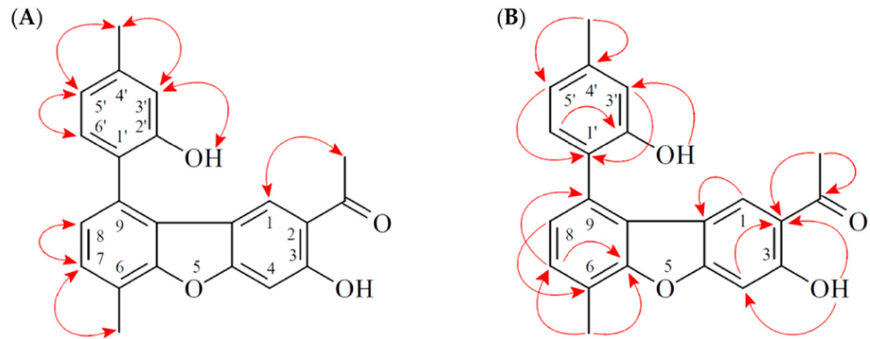
Figure 2. Key ROESY ( A ) and HMBC ( B ) correlations of 1 . Compound 2 was isolated as amorphous powder with molecular formula C 23 H 20 O 4 , Table 1. 1 H and 13 C NMR data of 1 and 2 . as determined by positive-ion HRESIMS, showing an [M + Na] + ion at m/z 383.12612 (calcd for C 23 H 20 O 4 Na, 383.12593). The presence of a conjugated carbonyl group was revealed by a band at 1645 cm − 1 in the IR spectrum, and was confirmed by the resonance at δ C 203.7 in the 13 C NMR spectrum. The 1 H NMR data of 2 were similar to eupatodibenzofuran A ( 1 ), except that the 2 (cid:48) -methoxy group [ δ H 3.70 (3H, s), δ C 55.5] of 2 replaced the 2 (cid:48) - hydroxy group [ δ H 4.97 (1H, s)] of 1 . This was supported by the ROESY correlations between OMe-2 (cid:48) ( δ H 3.70) and H-3 (cid:48) ( δ H 6.91) and by the HMBC correlations between OMe- 2 (cid:48) ( δ H 3.70) and C-2 (cid:48) ( δ C 156.7) (Table 1). The position of each substituent was supported by ROESY correlations between H-1 ( δ H 7.59)/Ac-2 ( δ H 2.40), Me-6 ( δ H 2.60)/H-7 ( δ H 7.27), H-7 ( δ H 7.27)/H-8 ( δ H 7.17), OMe-2 (cid:48) ( δ H 3.70)/H-3 (cid:48) ( δ H 6.91), H-3 (cid:48) ( δ H 6.91)/Me-4 (cid:48) ( δ H 2.49), and Me-4 (cid:48) ( δ H 2.49)/H-5 (cid:48) ( δ H 6.95) and by HMBC correlation between ‘H-1 ( δ H 7.59)/MeCO-2 ( δ C 203.7), C-3 ( δ C 162.9), C-4a ( δ C 161.3), C-9a ( δ C 121.7)’, ‘Ac-2 ( δ H 2.40)/C-2 ( δ C 116.0)’, ‘OH-3 ( δ H 12.62)/C-2 ( δ C 116.0)’, ‘H-4 ( δ H 7.05)/C-2 ( δ C 116.0), C- 9b ( δ C 117.8)’, ‘Me-6 ( δ H 2.60)/C-5a ( δ C 155.4), C-7 ( δ C 127.9)’, ‘H-7 ( δ H 7.27)/C-5a ( δ C 155.4)’, ‘H-8 ( δ H 7.17)/C-6 ( δ C 120.5), C-9a ( δ C 121.7), C-1 (cid:48) ( δ C 125.4)’, ‘H-6 (cid:48) ( δ H 7.28)/C- 9 ( δ C 130.6), C-2 (cid:48) ( δ C 156.7), C-4 (cid:48) ( δ C 139.8)’, ‘OMe-2 (cid:48) ( δ H 3.70)/C-2 (cid:48) ( δ C 156.7)’, ‘Me-4 (cid:48) ( δ H 2.49)/C-4 (cid:48) ( δ C 139.8), C-5 (cid:48) ( δ C 121.4)’ (Figure 3). The full assignment of 1 H and 13 C NMR resonances was confirmed by 1 H– 1 H COSY, ROESY (Figure 3A), HSQC, and HMBC (Figure 3B) techniques. According to the evidence above, the structure of 2 was elucidated as 1-(3-hydroxy-9-(2-methoxy-4-methylphenyl)-6-methyldibenzo[ b , d ]furan-2-yl)ethan-1- one, named eupatodibenzofuran B.